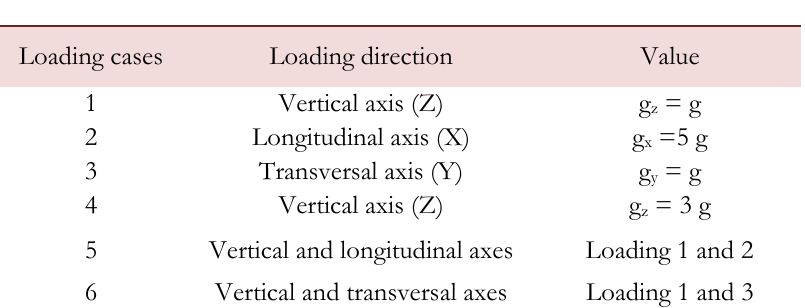
Table 4: Static loading cases.